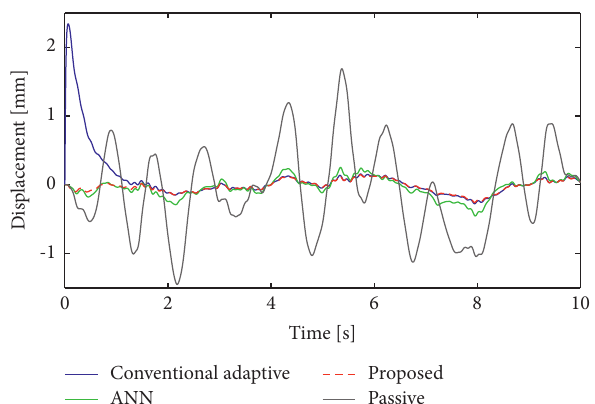
Figure 15: The comparison of sprung mass displacement responses under random excitation for three different